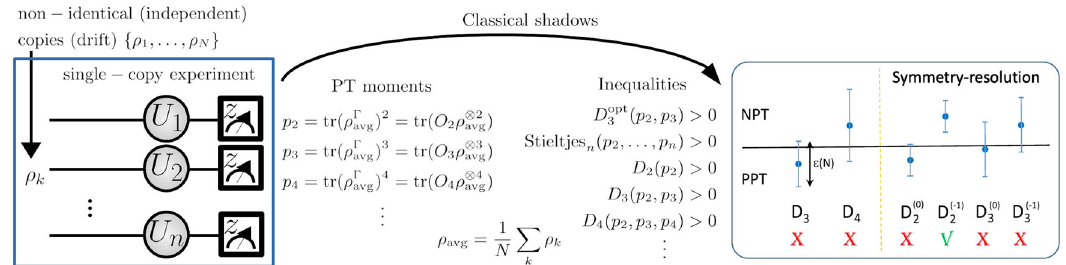
Fig. 1 An illustration of the proposed method for entanglement detection. We assume the experimentally relevant situation of a source producing non-identical but independent copies { ρ 1 , … , ρ N } ("drift''). Randomly chosen unitaries U i are applied to the qubits of each copy